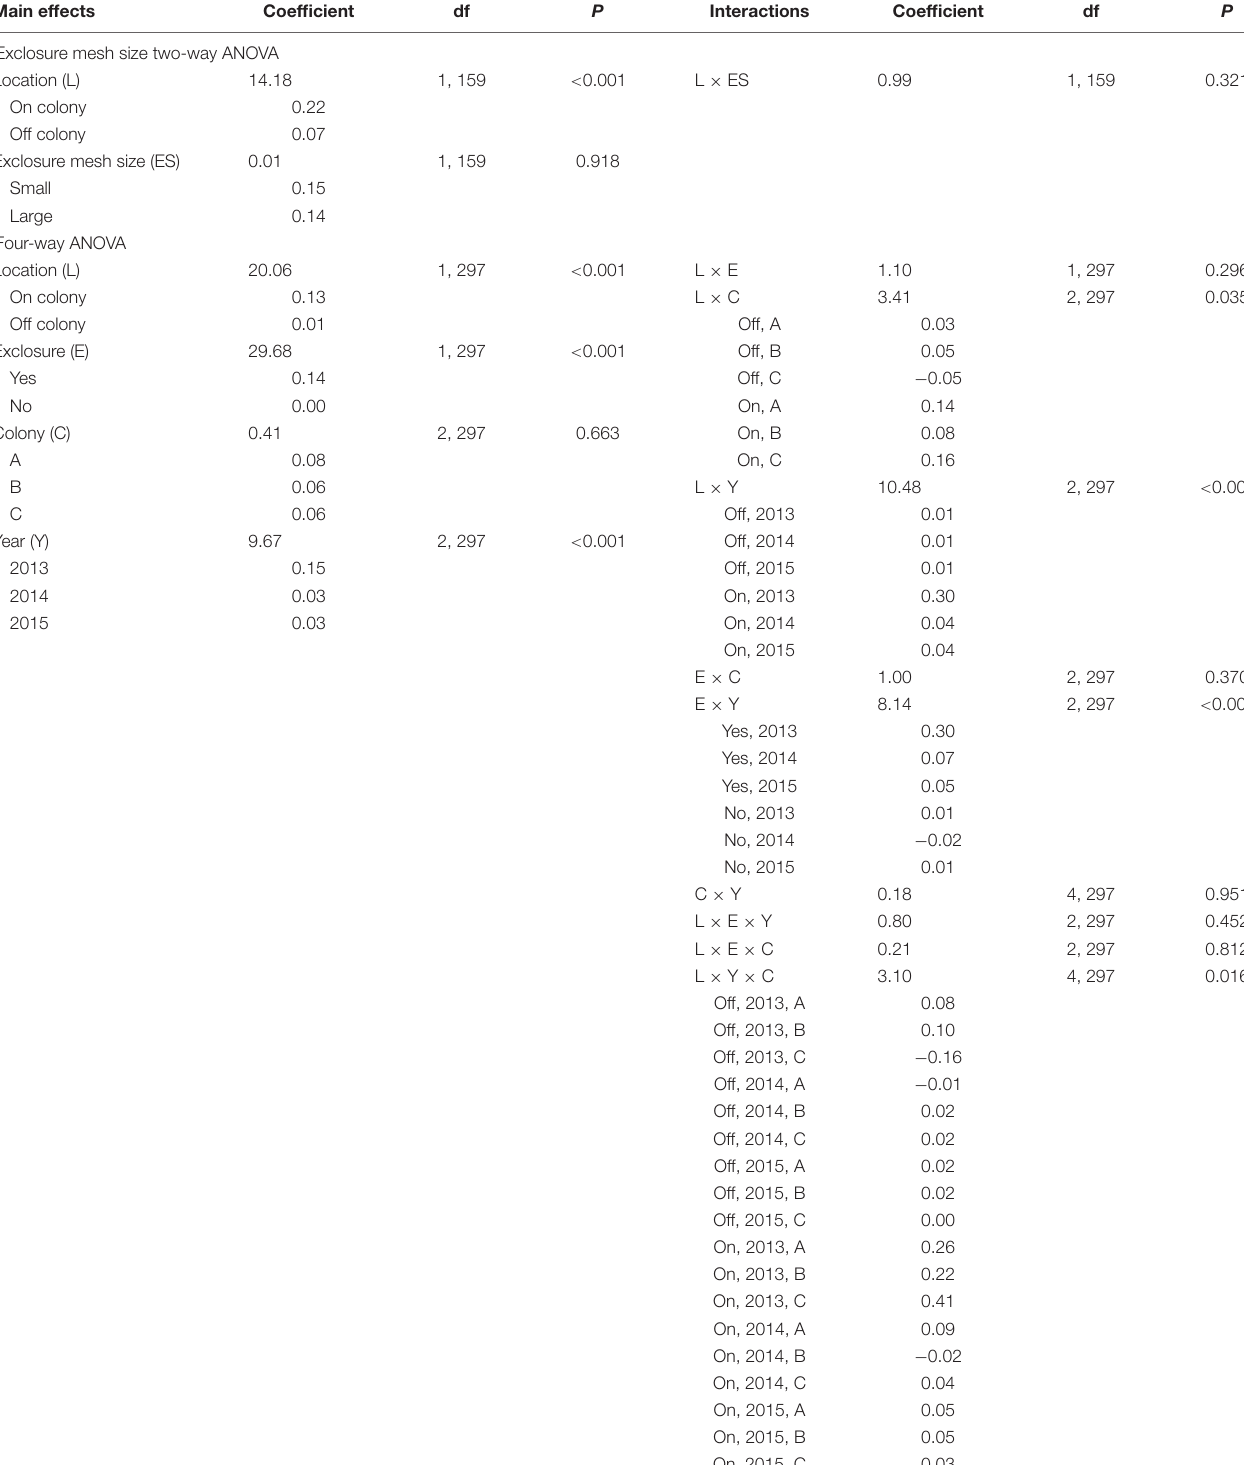
TABLE 1 | Summary of ANOVA outcomes for exclosure experiments and coefficients for main effects and significant interactions. F -value F